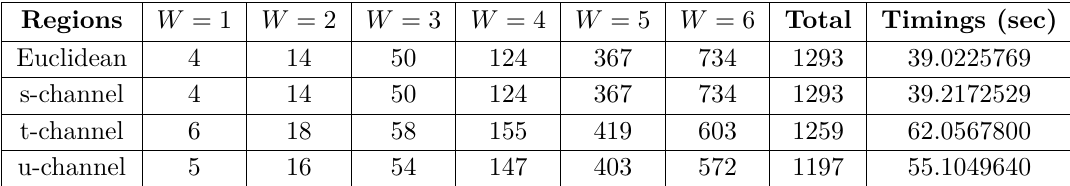
Table 2 . Number of GPLs per transcendental weight and per kinematic region, and timings for the numerical evaluation of the total GPLs. The quoted timings are obtained using the Ginsh command of PolyLogTools , running 1-core in a personal laptop (i7 processor, 8-core, 16GB RAM). The phase-space points that were used are (4.1) for the Euclidean region and (4.2), (4.3), (4.4) for the correspoing physical